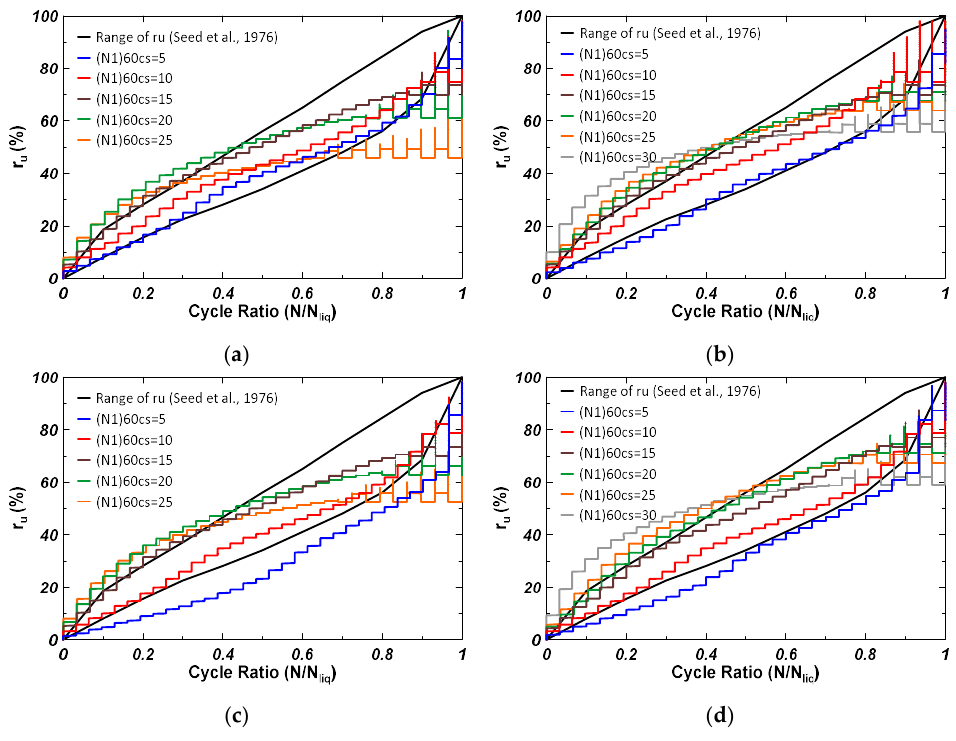
Figure 4. Accumulation of excess pore water pressure ratio and the associated cycle ratio of the Finn model. ( a ) HBF; ( b ) JRA96; ( c ) NCEER; ( d ) T-Y.